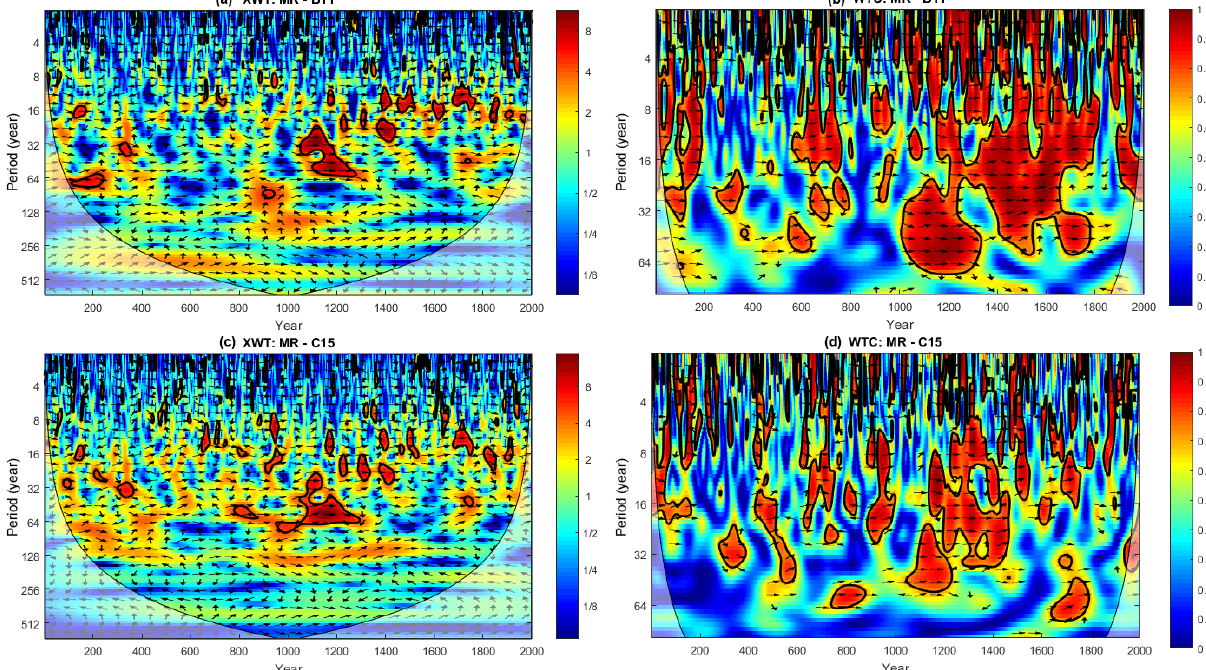
Figure 5. Cross-wavelet transform (XWT, a, c ) and squared wavelet coherence (WTC, b, d ) between MR-B11 (a, b) and MR-C15 (c, d) from AD1–2000. A 5% significance level against red noise is shown as a thick contour. Light shading depicts the cone of influence. Right-pointing arrows show in-phase and left-pointing arrows show anti-phase